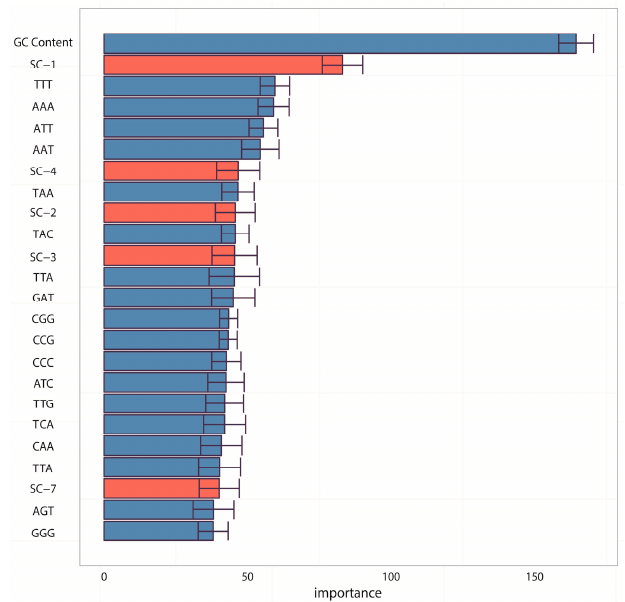
Figure 3. Top 24 important features by normalized regression coefficients in linear kernel SVM. The importance of the features was obtained by resampling statistics and the corresponding error bars of the top 24 features are represented. The colors represent different groups of features: DNA composition is blue, and sequence complexity is red. is blue, and sequence complexity is red.